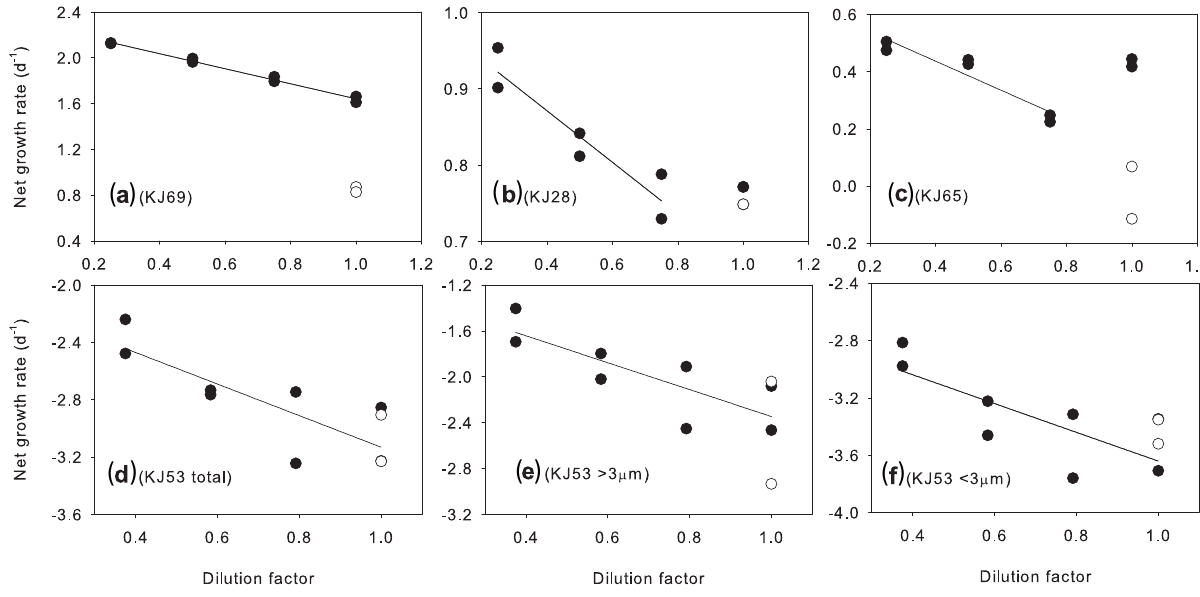
Figure 3. Examples of dilution experiment plots of net phytoplankton growth rate as a function of dilution factor. (a) Linear feeding responses in the dilution experiment at KJ69; (b) saturated feeding responses in the dilution experiment at KJ28; (c) saturated-increasing feeding responses in the dilution experiment at KJ65; (d–f) negative phytoplankton growth rates at KJ53, (d) for total phytoplankton, (e) for the size fraction > 3µm and (f) for the size fraction < 3µm; the black circle indicates experimental bottles enriched with addition nutrients; the open circle indicates experimental bottles without nutrient amendment. Table 3. Comparison of phytoplankton growth and mortality rates between two size fractions in the southern South China Sea in November 2010. µ n , phytoplankton growth rates with nutrient amendment (d − 1 ); µ , phytoplankton growth rates without nutrient amendment (d − 1